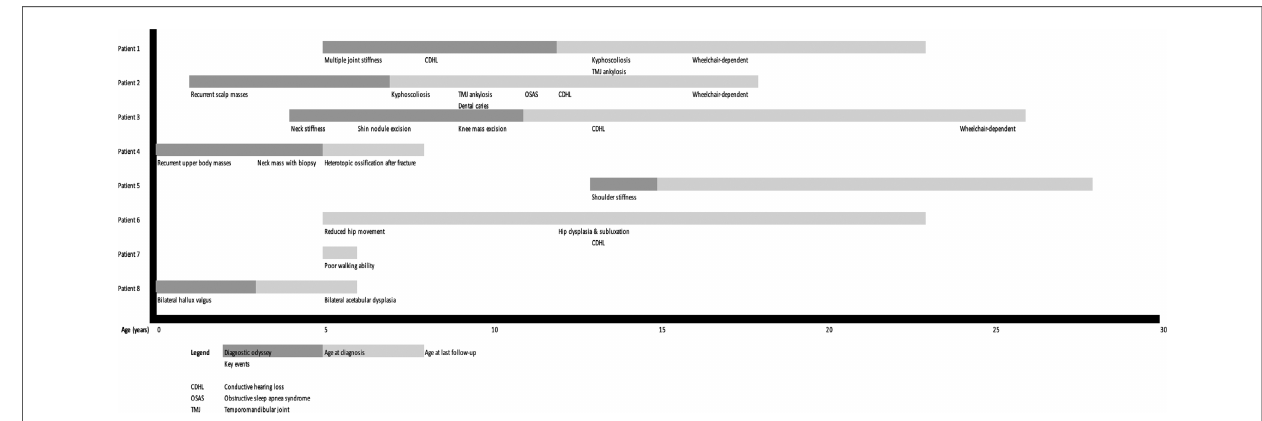
FIGURE 1 Timeline demonstrating the clinical courses of all eight patients with relation to